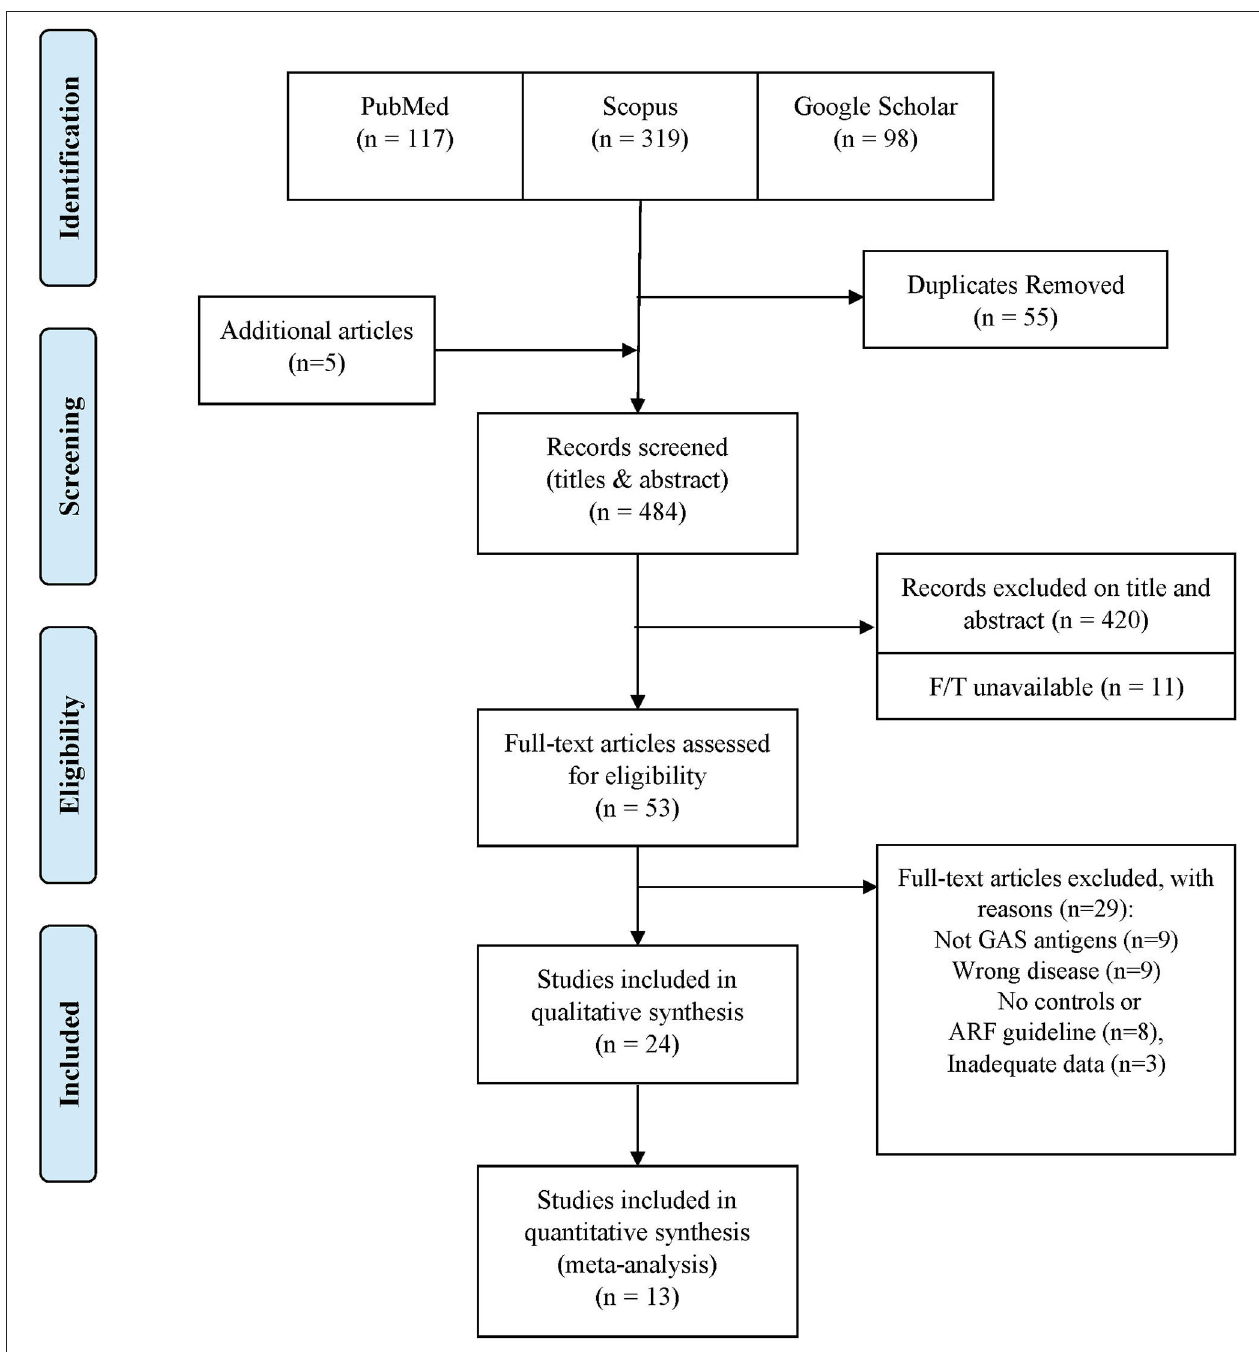
FIGURE 1 | Schematic PRISMA flow diagram of the literature search.